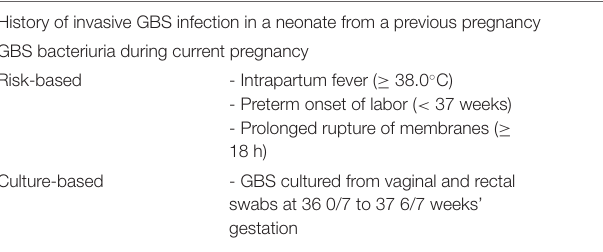
TABLE 1 | Indications for intrapartum antibiotic prophylaxis (IAP) (see Footnote 1; Centers for Disease Control Prevention., 2010). History of invasive GBS infection in a neonate from a previous pregnancy GBS bacteriuria during current pregnancy